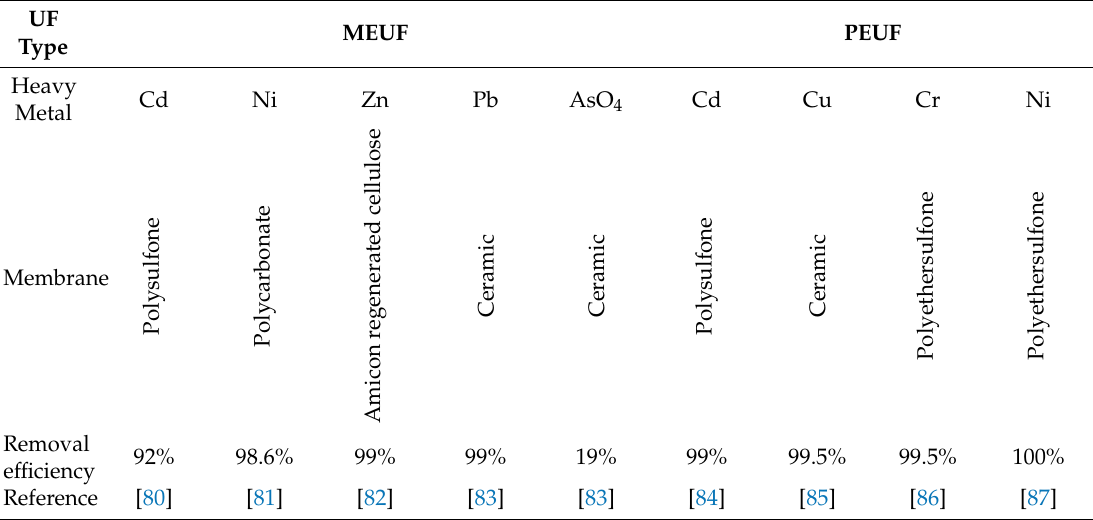
Table 4. Removal e ffi ciency of heavy metals by membrane technologies.